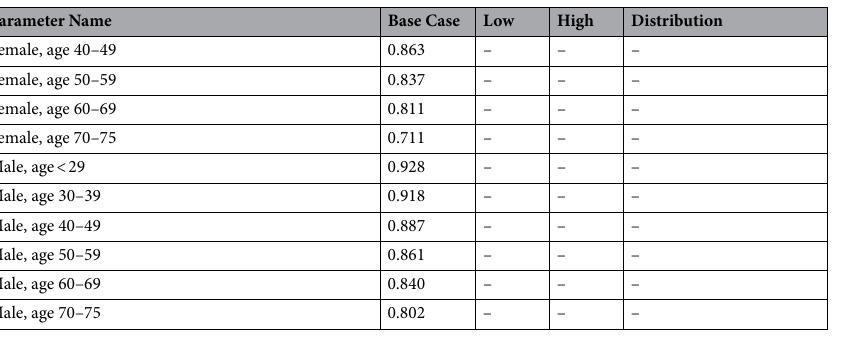
Table 2. Model parameters used in the MATCH-Georgia model. RDT rapid diagnostic tests, RNA ribonucleic acid confirmation test, APRI aspartate aminotransferase to platelet ratio test, FIB4 fibrosis-4 test, cAg core